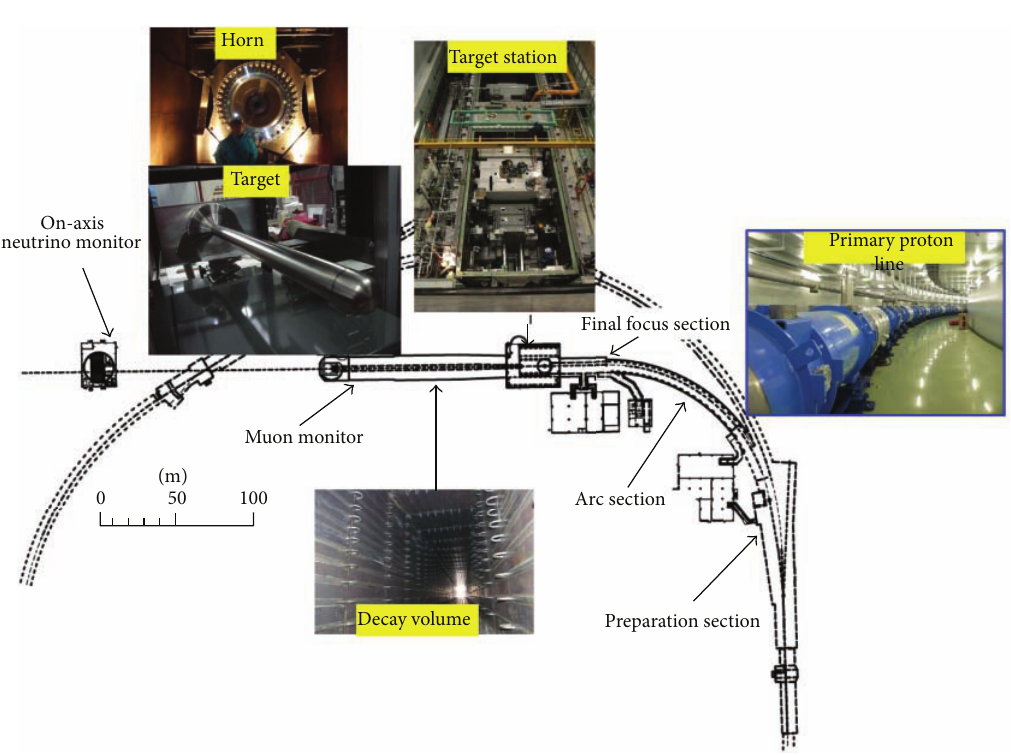
Figure 10: J-PARC neutrino beam